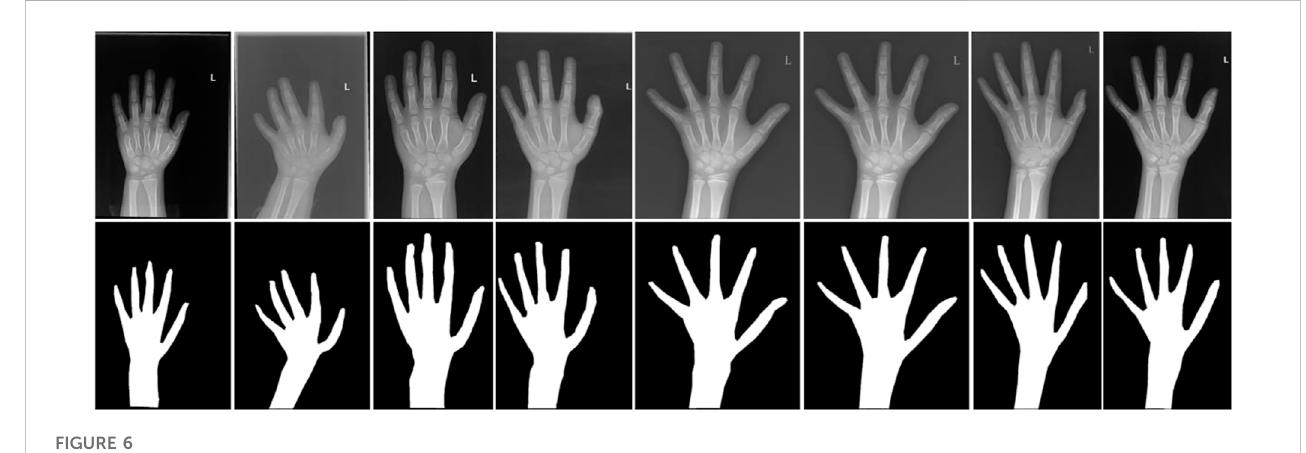
FIGURE 6 Results of hand bone segmentation.